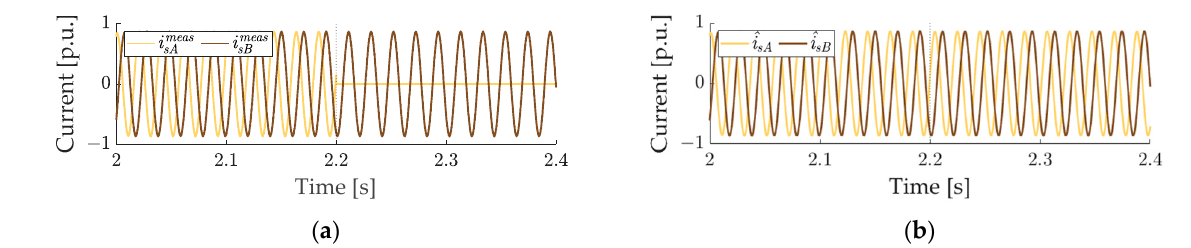
Figure 15. Measured ( a ) and estimated ( b ) stator currents in phases A and B .